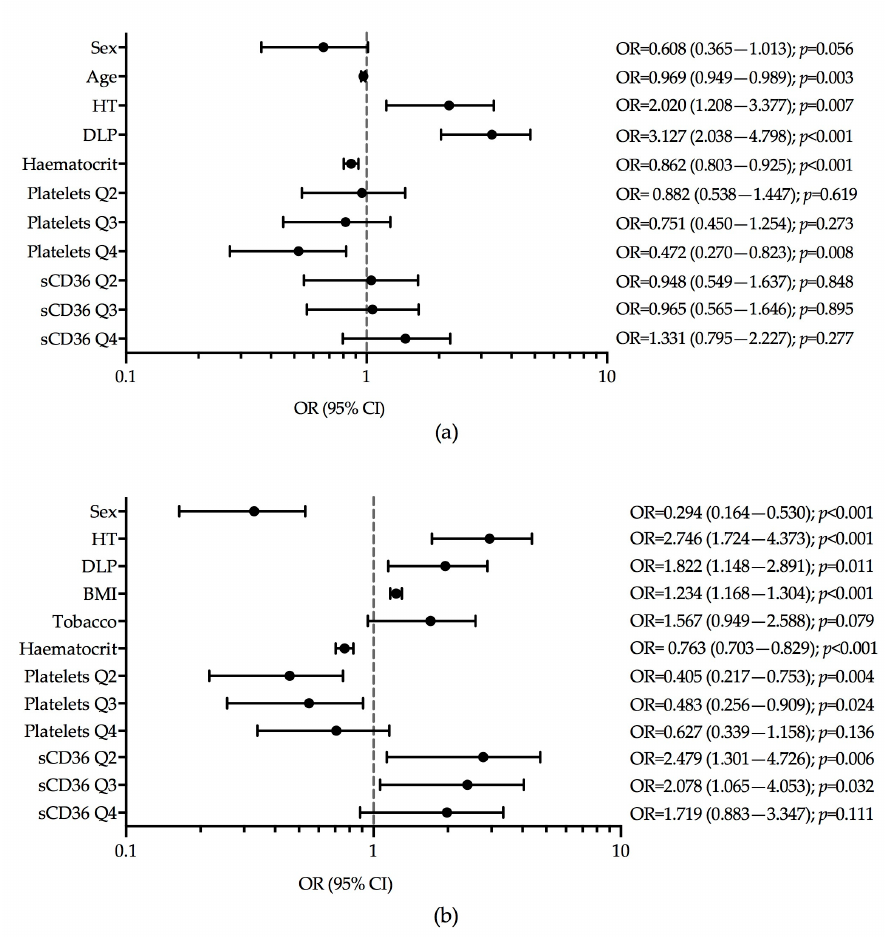
Figure 2. Logistic regression models for presence of diabetes. ( a ) T1D versus non-diabetic group (Hosmer and Lemeshow test p -value = 0.789); ( b ) T2D versus non-diabetic (Hosmer and Lemeshow test p -value = 0.686). Tobacco, tobacco exposure.